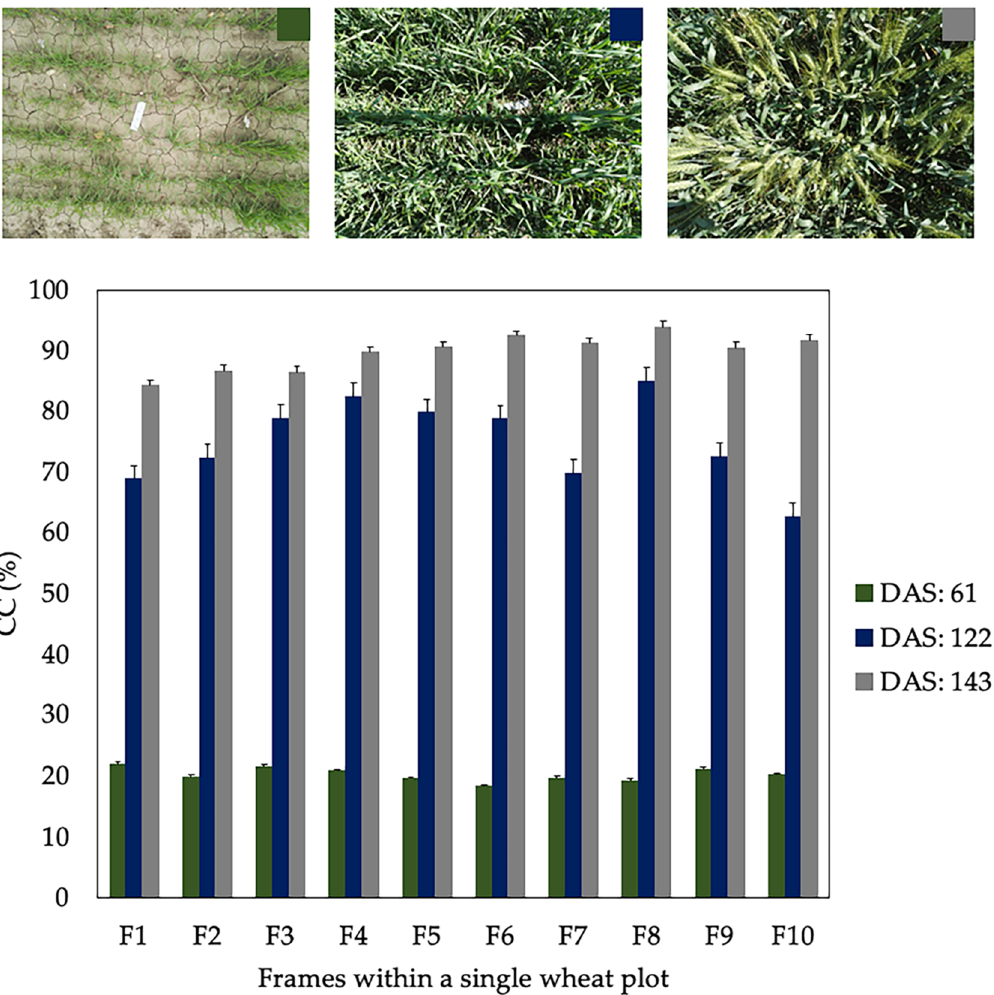
Figure 7. Canopy cover (CC) values for 10 frames within a single wheat plot on different days after sowing (DaS) during 2017–18 season. The error bars represent the standard deviation (SD) of the